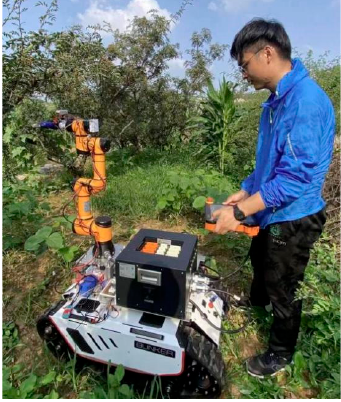
Figure 10. Peppercorn-picking robot test platform.